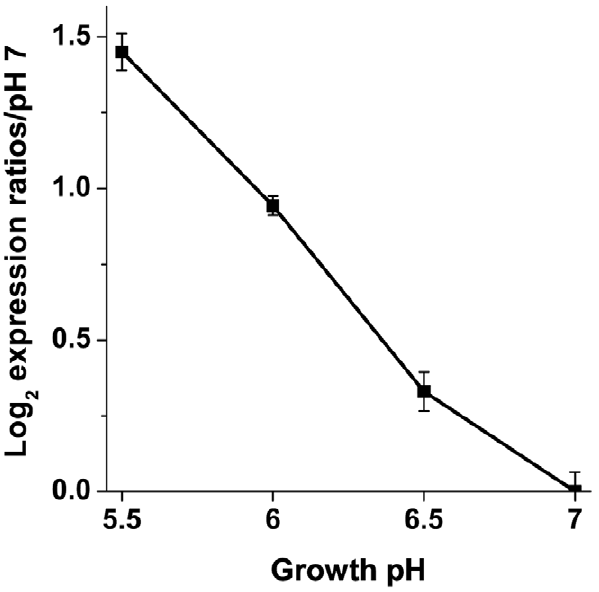
Figure 3. hycE gene expression in W3110. RNA was isolated from anaerobic cultures grown to log phase at pH 5.5, 6, 6.5, and 7. Real- Time PCR was used to measure the mRNA levels of hycE , the large subunit of Hyd-3. Expression levels were normalized to the pH 7 control. Error bars represent SEM, n=3 (RNA from independent cultures). The experiment was conducted twice.